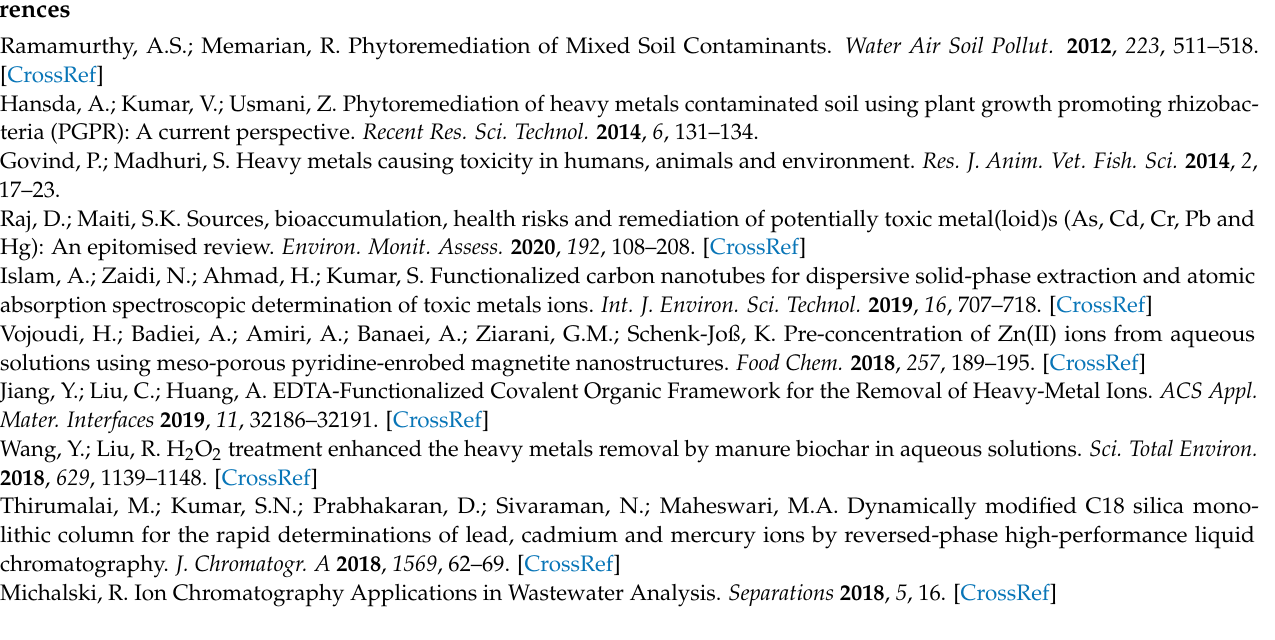
AgNCs-PMAA solution. Figure S2: Interference tests on the AgNCs-PMAA solution. Table S1: Pb(II) concentrations and their errors, in normal and logarithm forms. Table S2: Parameters calculated by the fitting process. Table S3: Parameters for the determination of quantum yield of the AgNCs samples. Figure S3: Concentrations of the Tests determined by synthesis (red bars), fluorescence method (green bars) and ICP-OES (blue bars). Table S4: Composition of commercial mineral waters. Table S5: Comparative table about the precision (RSD) of different fluorescent